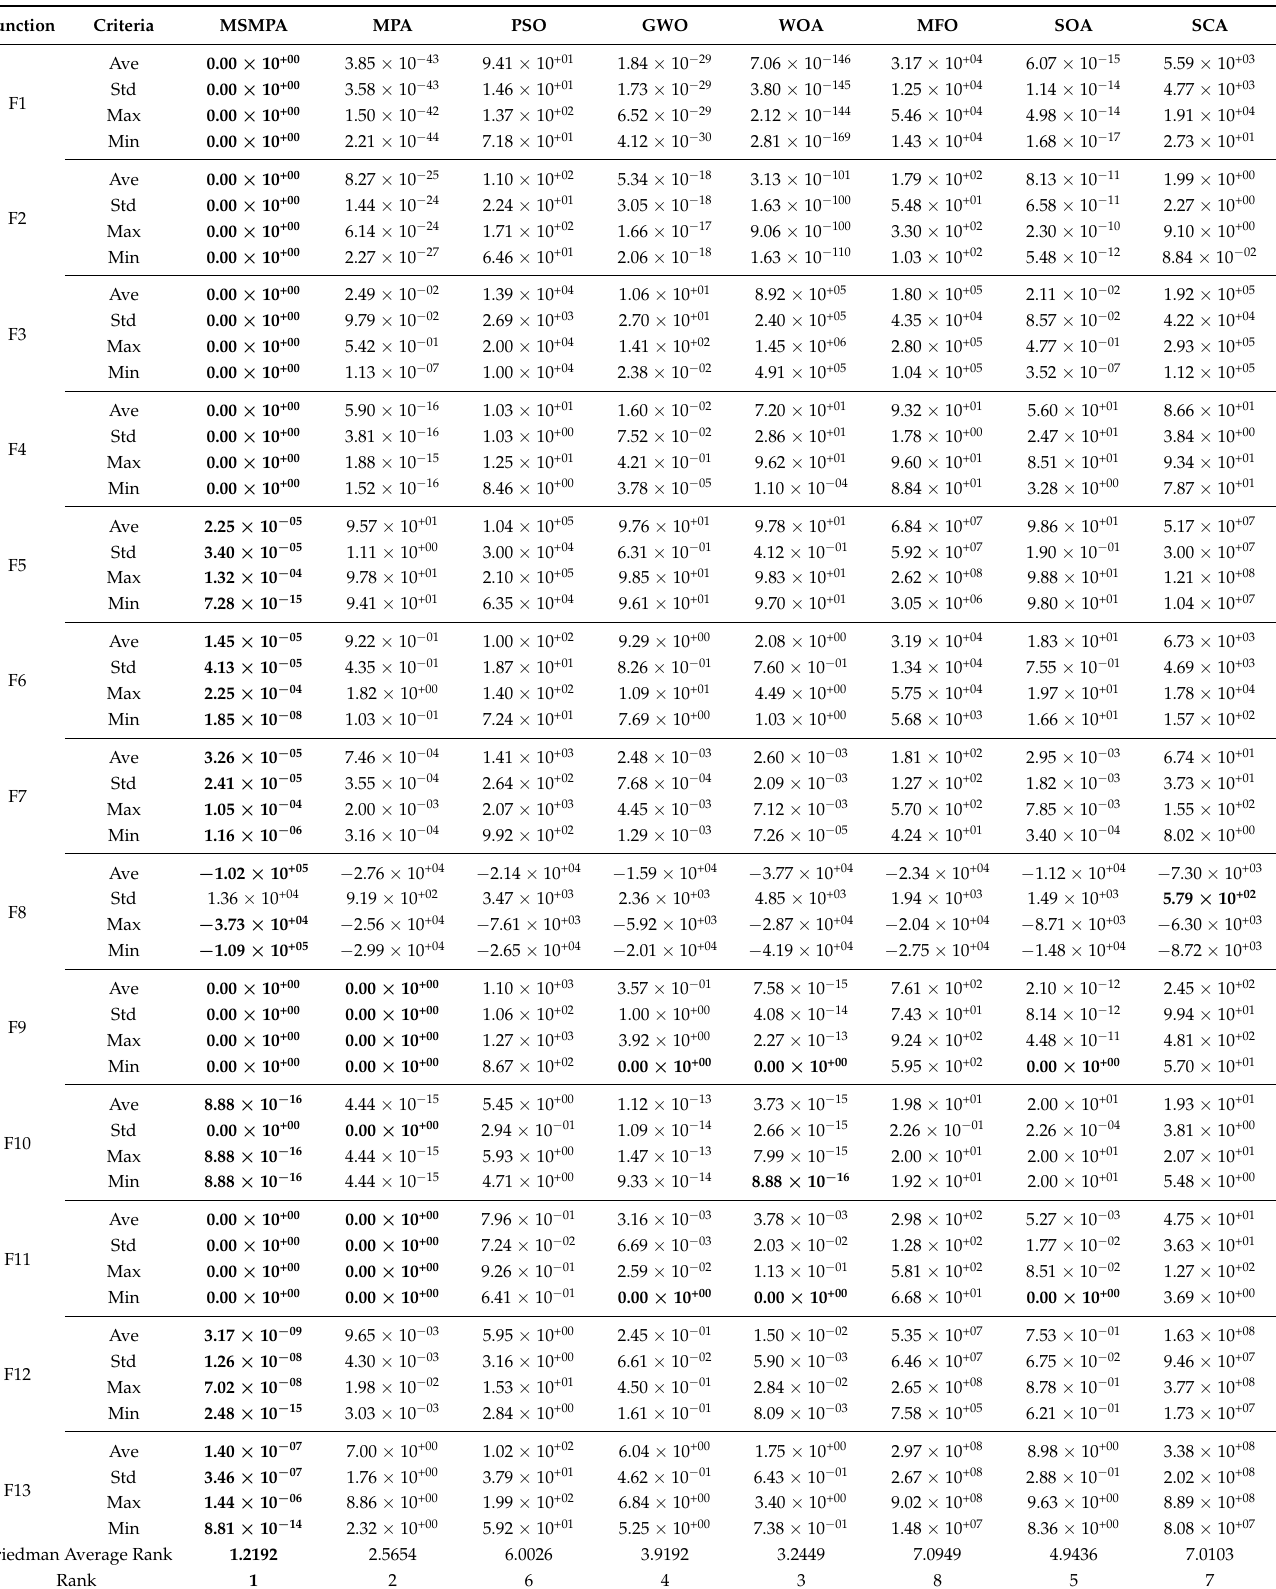
Table A4. Test results for each high-dimensional function in dimension